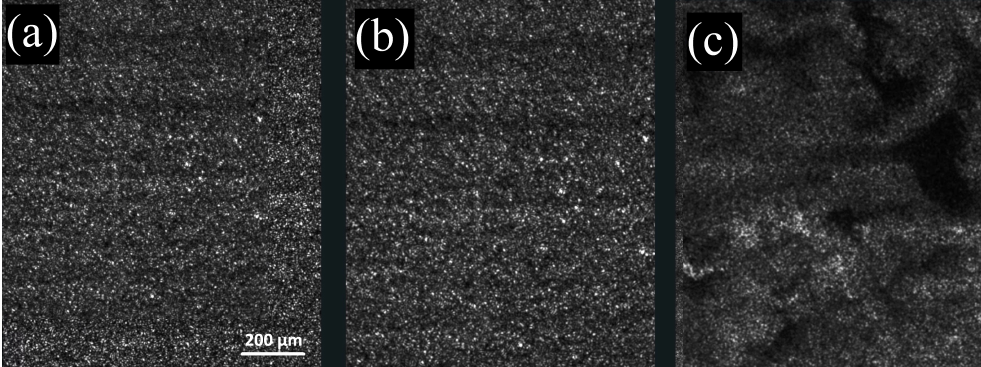
Figure 3. ( a ) Speckle pattern of sample H, two hours after its preparation. ( b ) Speckle pattern of sample L, two hours after its preparation. ( c ) Speckle pattern of a sample with the same composition as sample L, but without the addition of acetic acid, two hours after its preparation. In this case, a heterogeneous speckle pattern is clearly visible, demonstrating the sample’s inhomogeneity.